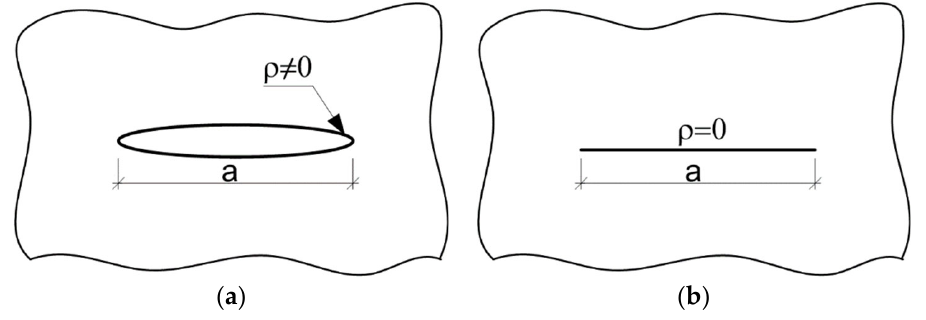
Figure 1. Diagrams of material defects in concrete: ( a ) crack, ( b ) gap [66–68].